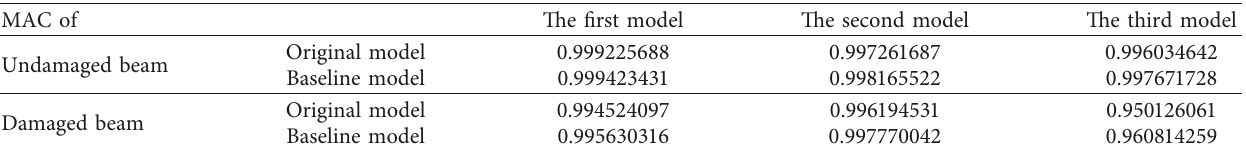
Figure 18: Modal shapes of the damaged beam of (a) the first modal, (b) the second modal, and (c) the third modal. Table 7: MAC of the experimental beam.